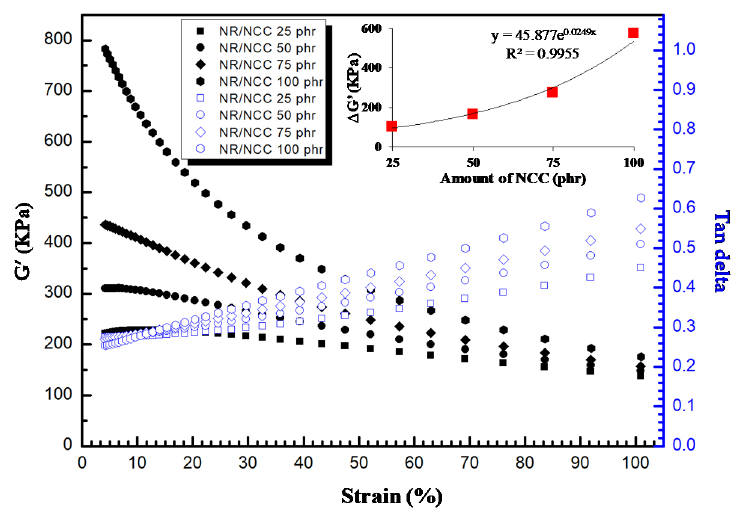
Figure 10. Payne effect ( left ; solid) and damping factor (tan delta, right ; open) as a function of strain for NR with NCC particles at 25–100 phr.